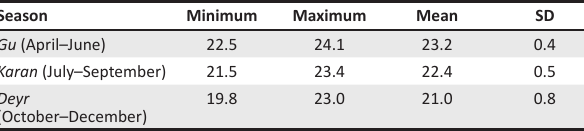
TABLE 10: Seasonal mean temperature descriptive statistics (1983–2017).